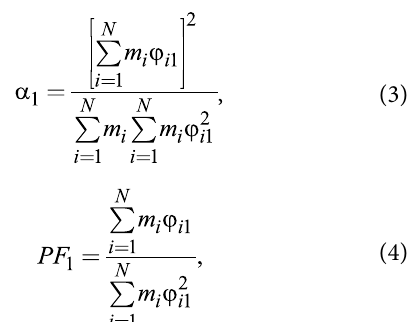
Fig. 3. Plastic behavior (a), b ilinear material model (b) and linear response spectrum (c) of the reinforcement